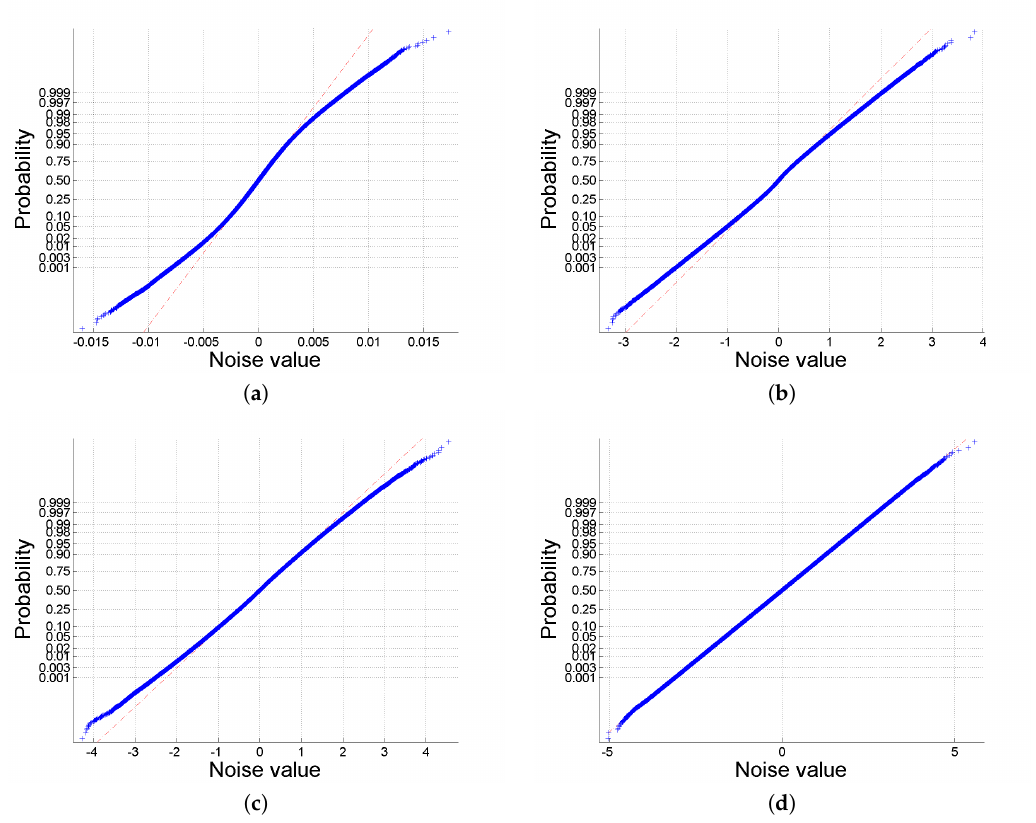
Figure 8. Normal probability plot for the noise: ( a ) before whitening, and after whitening using ( b ) SDNW-MLR; ( c ) SDNW-MWF; ( d ) SDNW-MWPT-MWF, with SNR INPUT = 40